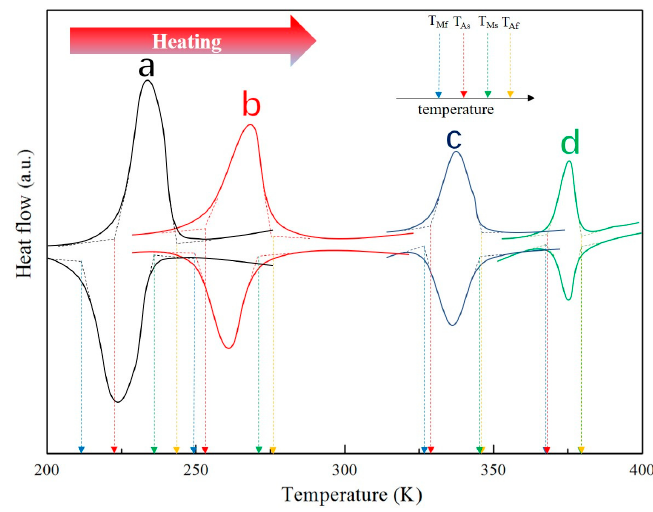
Figure 6. Differential scanning calorimeter ( DSC) curve of Co 33 Ni 31 Al 27 Fe 9 alloy with furnace cooled and RS: ( a ) furnace cooled; ( b ) D8; ( c ) D4; and ( d ) D1.